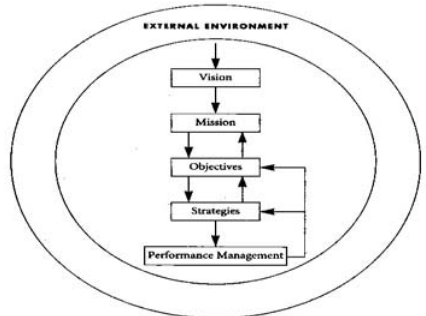
Figure 1:Mike Hudson’s Strategic Management Process Model